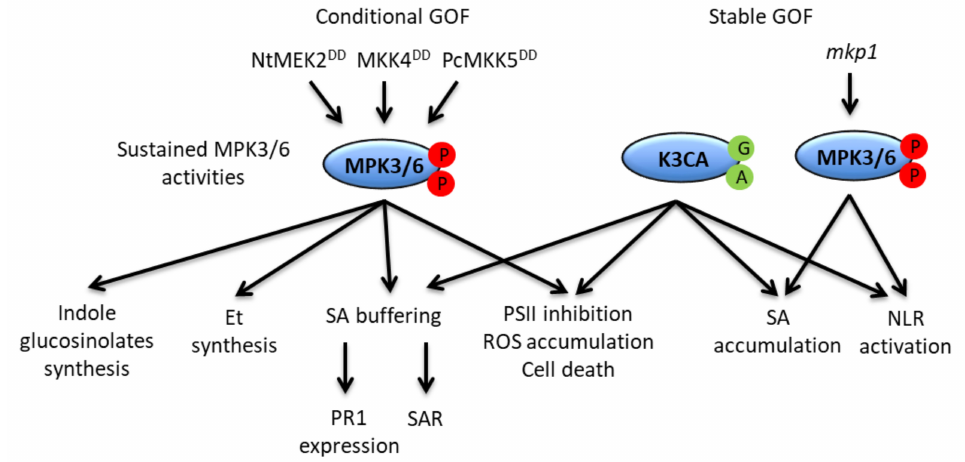
Figure 5. Representation of the functions of sustained MPK3 / 6 activities. The functions are indicated in connection with the experimental approaches which allowed their elucidation: either conditional gain-of-function (GOF) approaches through the steroid-inducible expression of di ff erent constitutively active MAP2Ks, or stable GOF approaches through the endogenous expression of a constitutively active MPK3 (K3CA), and as a result of the mkp1 mutation. For detail, see the main